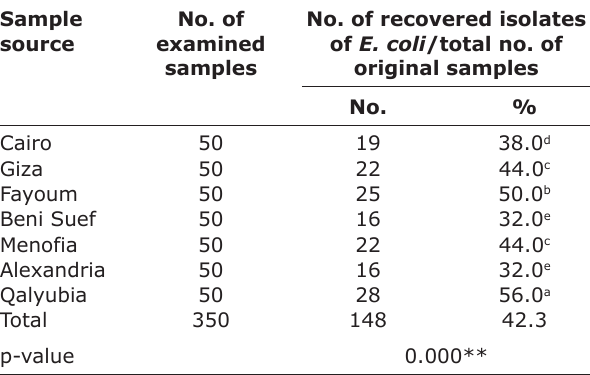
Table-5: Prevalence rates of E. coli isolates from milk and milk